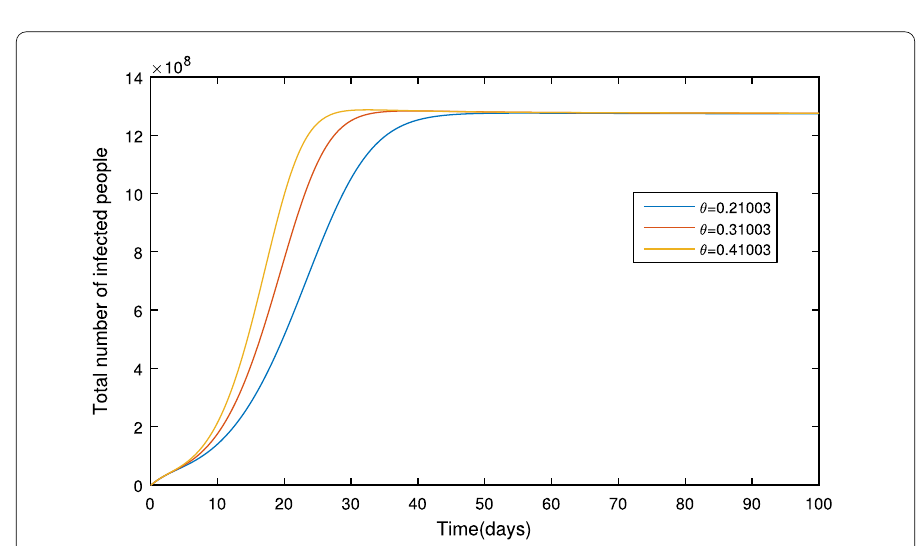
Figure 5 The total number of infected people for various values of θ